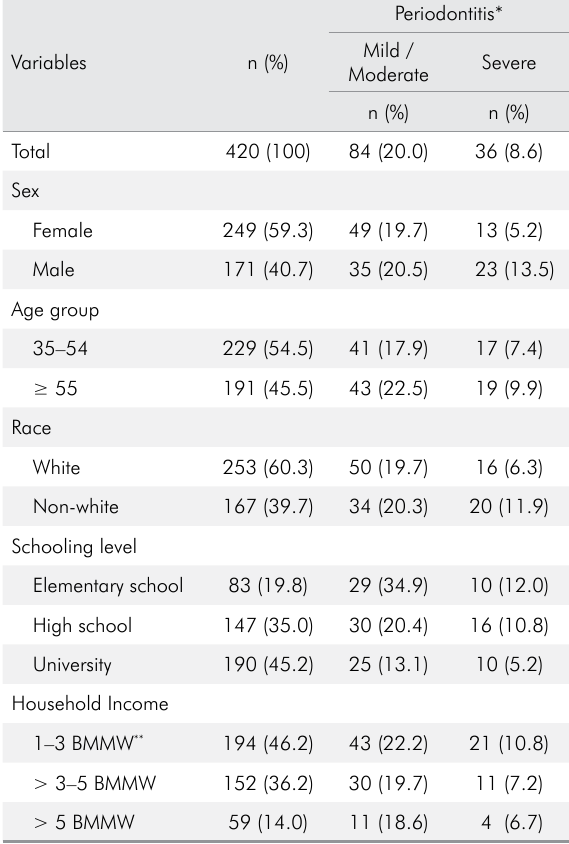
Table 1. Sample distribution according to sociodemographic variables and prevalence of periodontitis. Advento study. São Paulo, 2016.